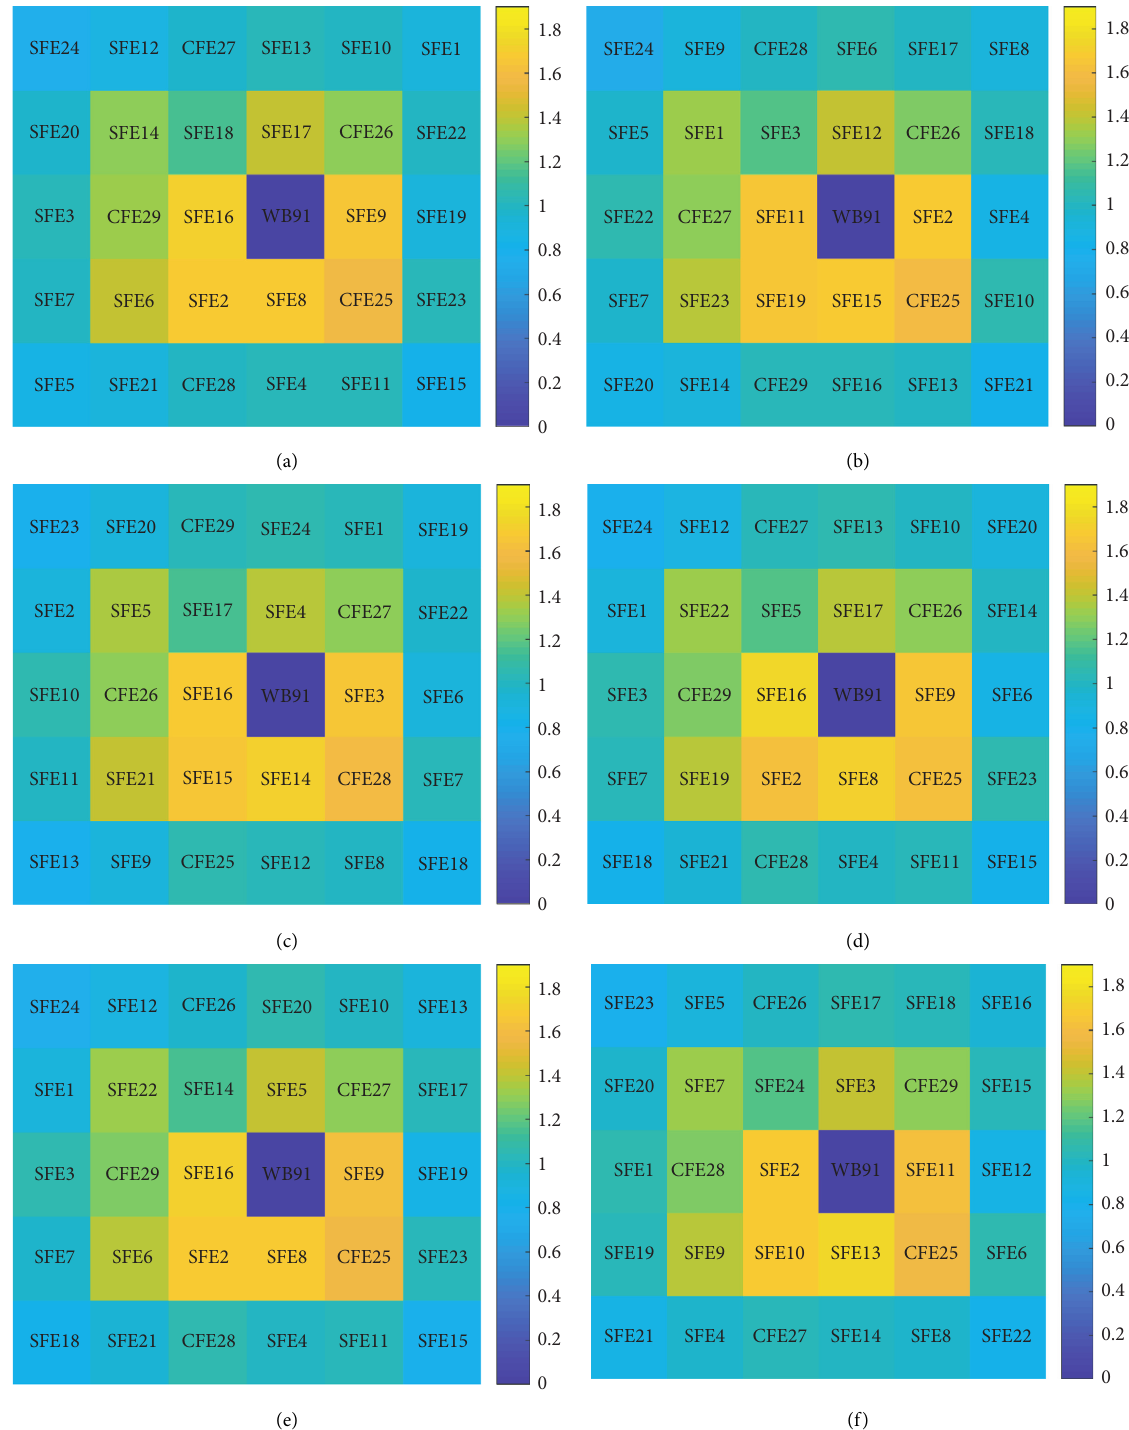
Figure 10: Optimal loading patterns for the group generations having the same thermal flux. (a) Group 1: ϕ (b) Group 2: ϕ th � 7.93645 × 10 13 ( ± 0.00022). (c) Group 3: ϕ th � 7.93116 × 10 13 ( ± 0.00026). (d) Group 4: ϕ th � 7.93119 × 10 13 ( ± 0.00023). (e) Group 5: ϕ th � 7.93173 × 10 13 ( ± 0.00025). (f) Group 6: ϕ th � 7.93501 × 10 13 ( ±